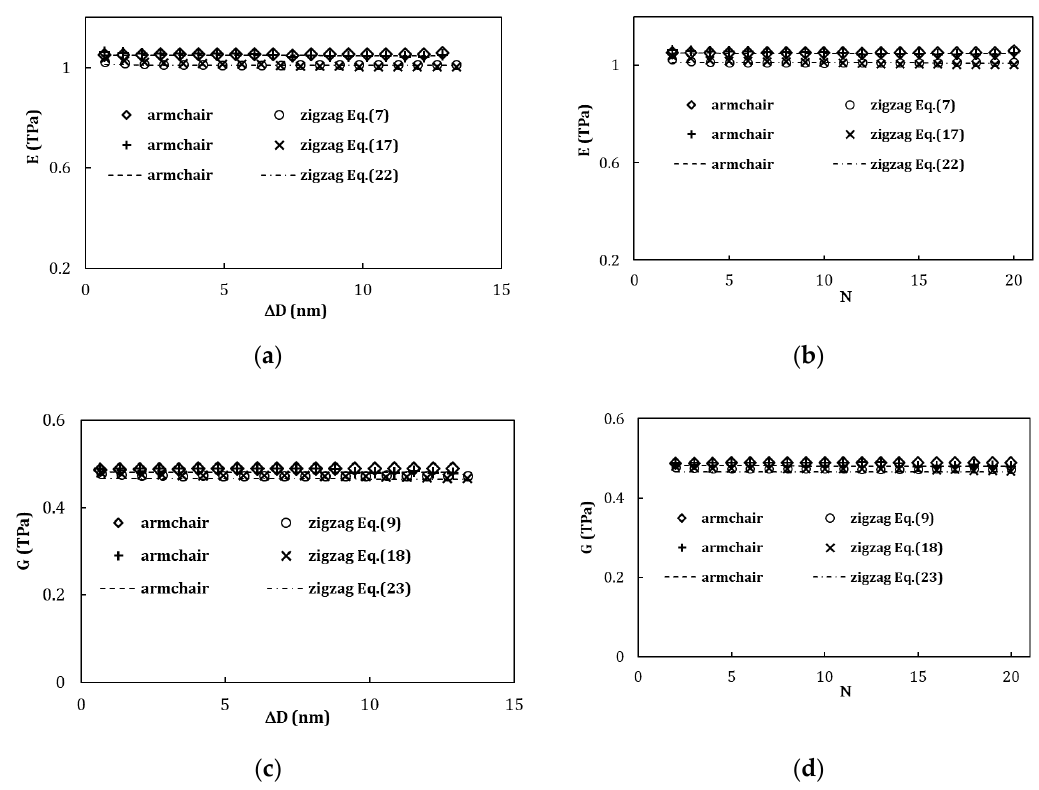
Figure 5. Evolutions of the Young’s modulus of MWCNTs with: ( a ) the difference between outer and inner layers diameters, ∆ D , and ( b ) the number of layers, N , constituting the MWCNT and evolutions of the shear modulus of MWCNTs with: ( c ) ∆ D and ( d ) N . The Young’s moduli of MWCNTs were evaluated by Equations (7) and (17), from the numerical simulations results, and analytically by Equation (22). The shear moduli of MWCNTs were evaluated by Equations (9) and (18), from the numerical simulations results, and analytically by Equation (23).